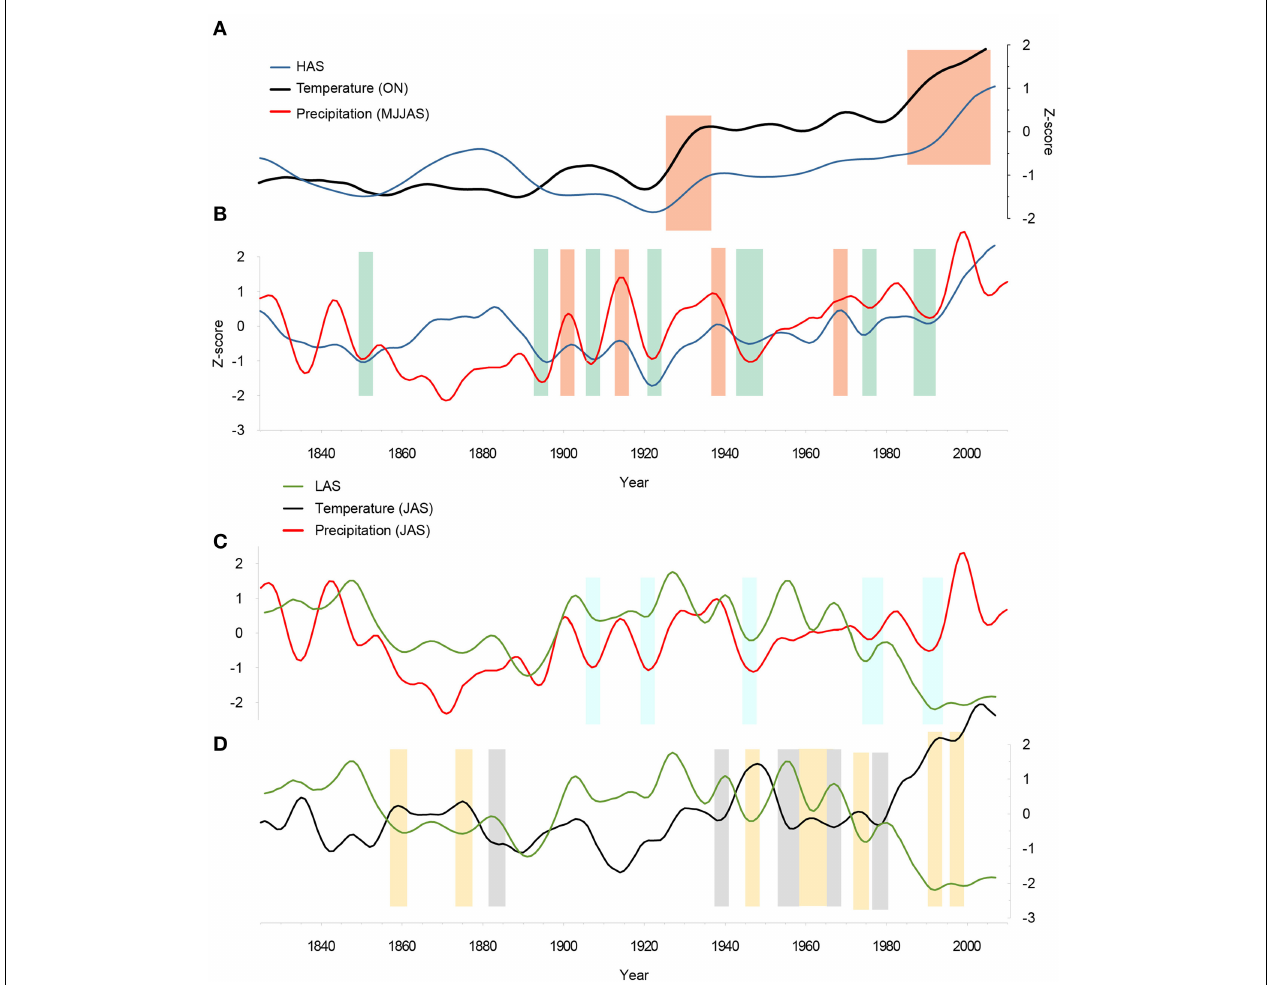
FIGURE 4 | Comparison of low-pass filtered ARGC detrended chronologies and key climate variables for the period 1837–2007: (A) 20–year low-pass filtered HAS chronology and Fall (ON) temperature; (B) 10–year low-pass filtered HAS chronology and May to September precipitations; (C) 10–year low-pass filter LAS chronology, summer (JJA) temperatures and (D) precipitations. Both the climate series and the tree-ring chronologies were transformed to z scores over the 1837–2007